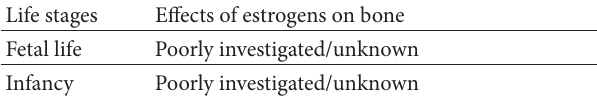
Table 1: Role of estrogens on male bone throughout